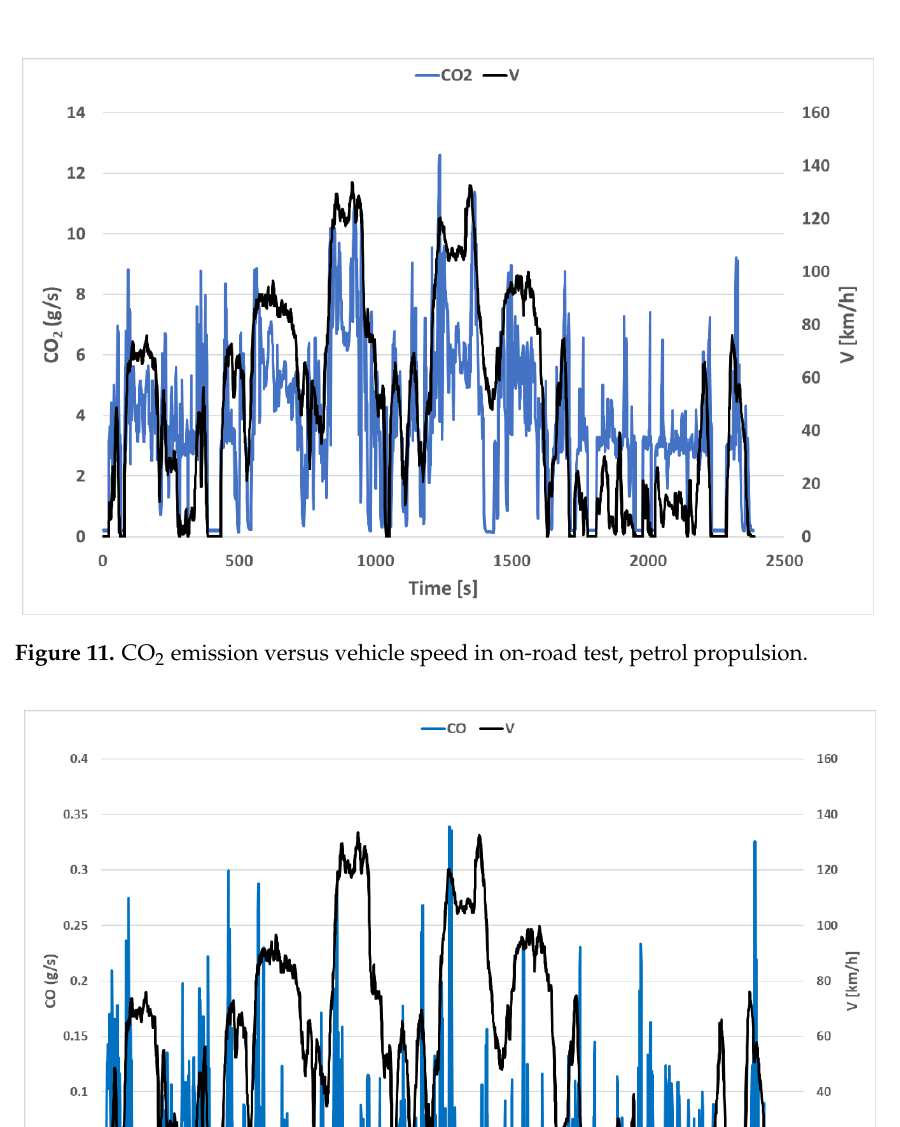
Figure 13. CO 2 emission versus vehicle speed in on-road test, CNG propulsion.